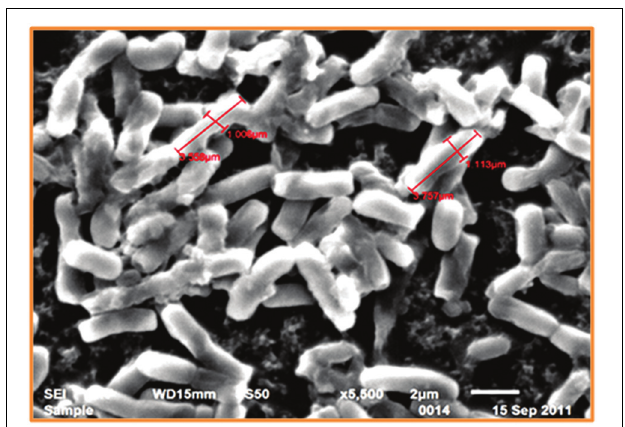
FIGURE 1 | Scanning electron microscopy of Thermoactinomyces sp.